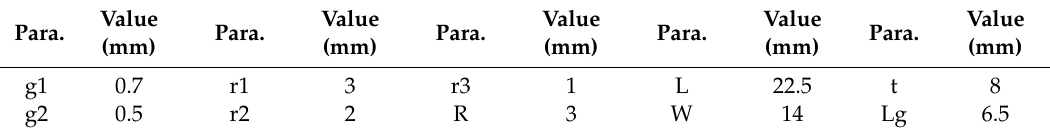
Figure 1. Metamaterial unit cell: ( a ) 2D view unit cell structure and ( b ) 3D view simulation setup (unit cell size 4.9 × 4.9 × 1.6 mm). Table 2. Parameters dimensions of the proposed unit cell and